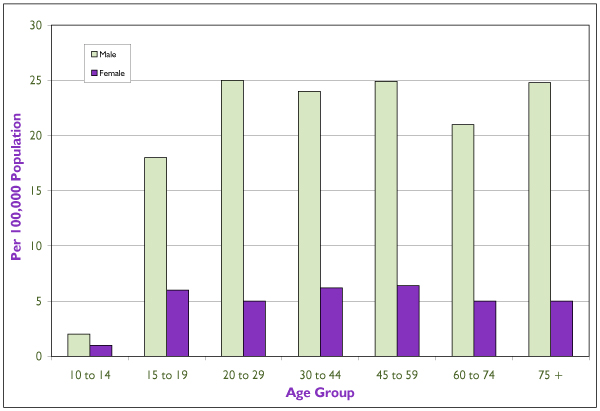
Age-specific suicide rates, by sex, Canada, 1998 Source: Canadian Vital Statistics Database (Health Rep 2002;13(2))